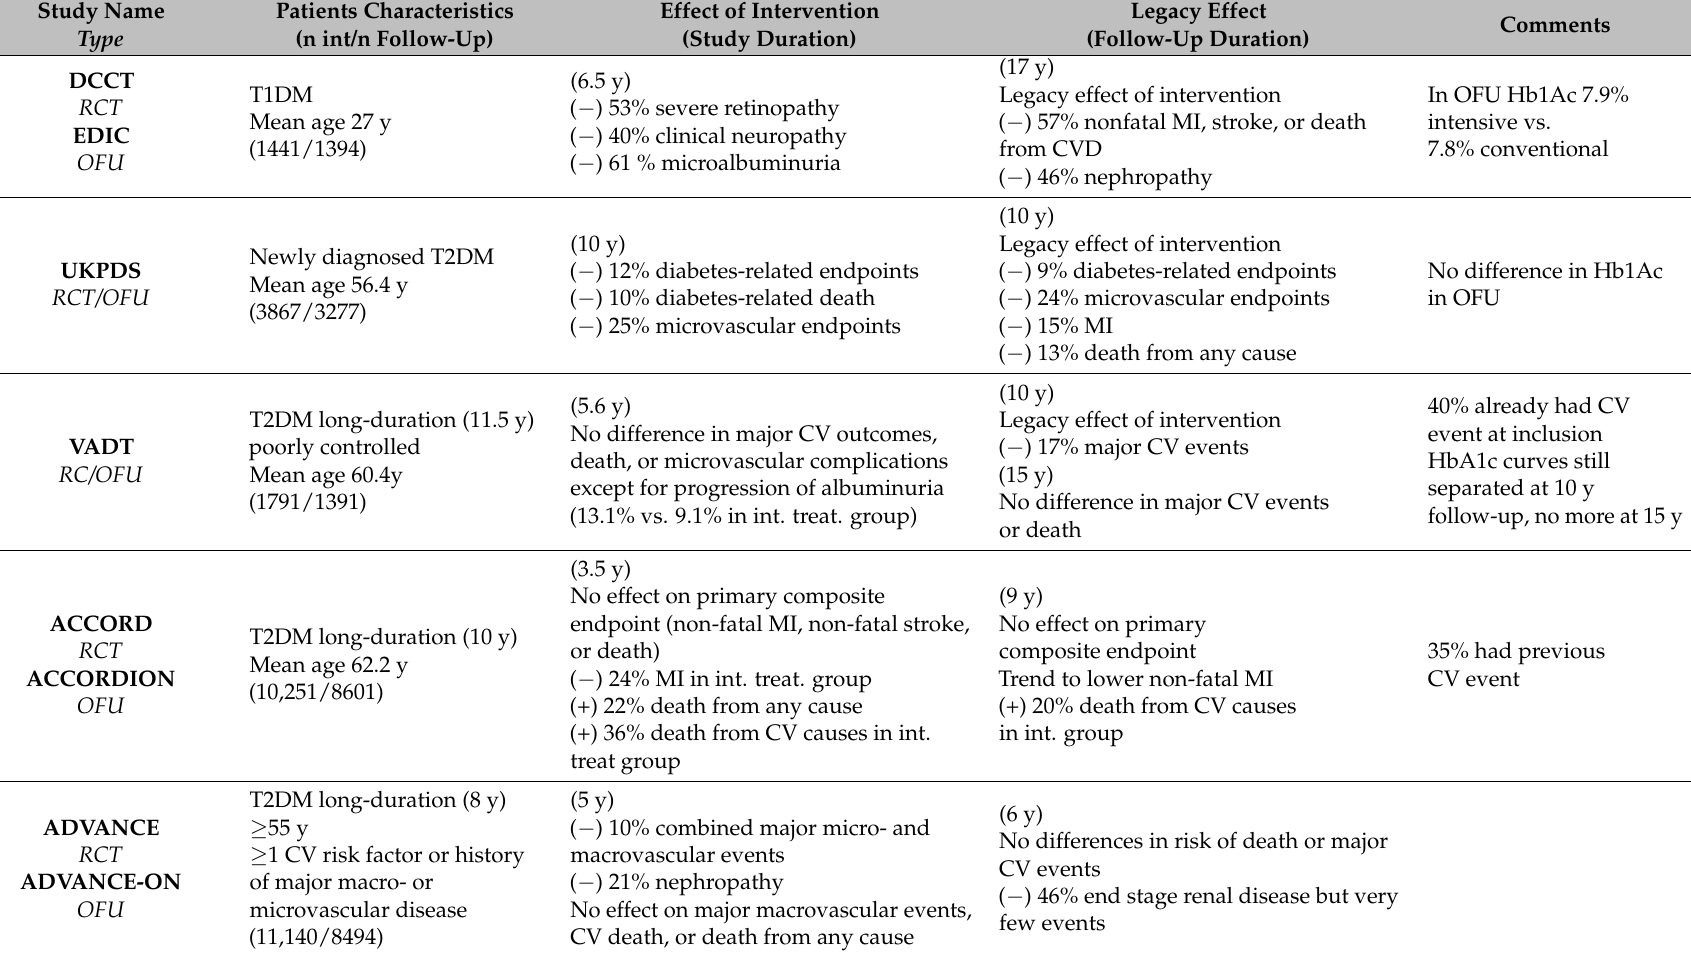
Table 1. Studies evaluating legacy effect in cardiovascular risk factors